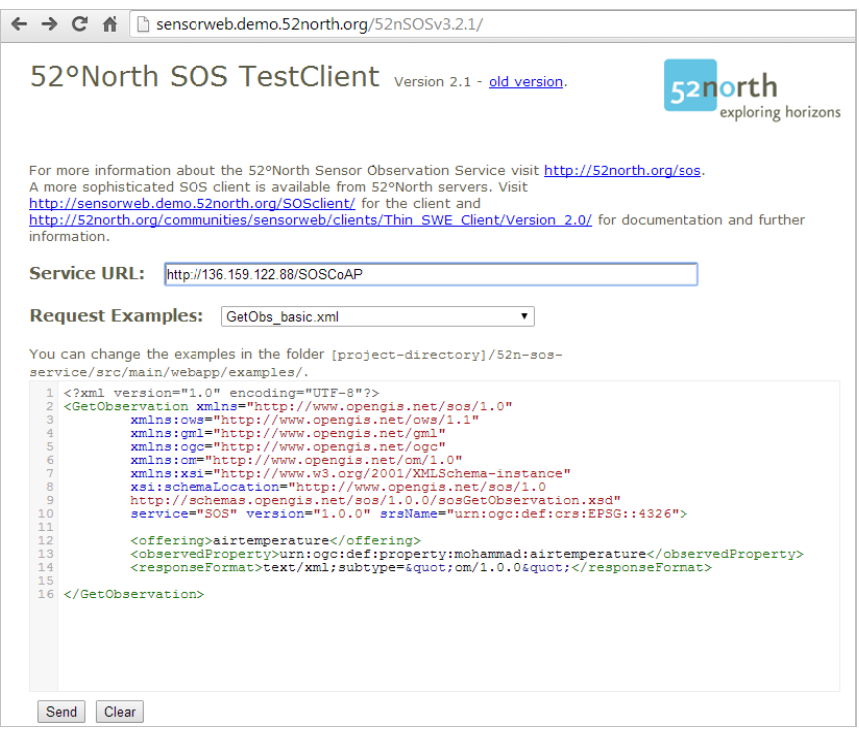
Figure A4. GetObservation request to the SOSCoAP proxy using 52 North test client tool.